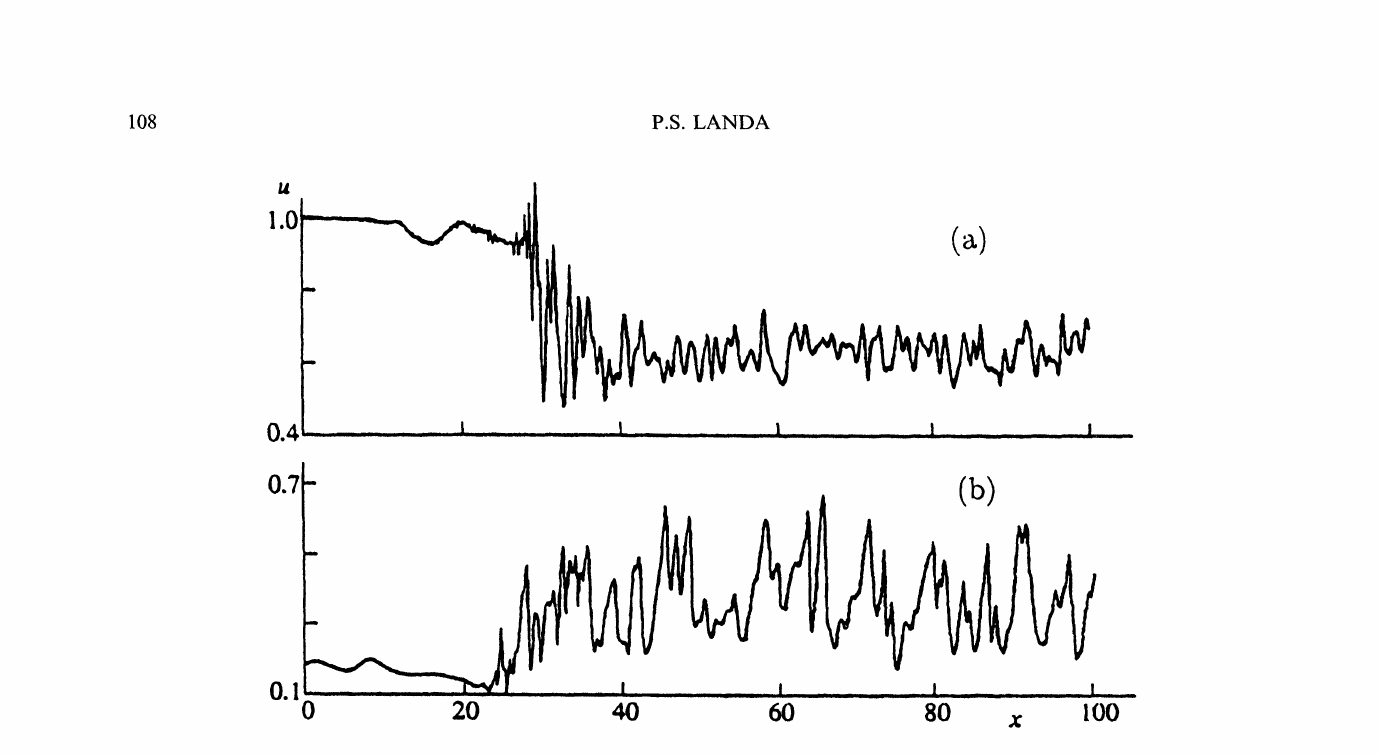
FIGURE 6 Instantaneous distributions of the steady longitudinal velocity component for A/uo--0.04: (a) close to the pipe axis (for r/R =0.02) and (b) close to the pipe wall (for r/R